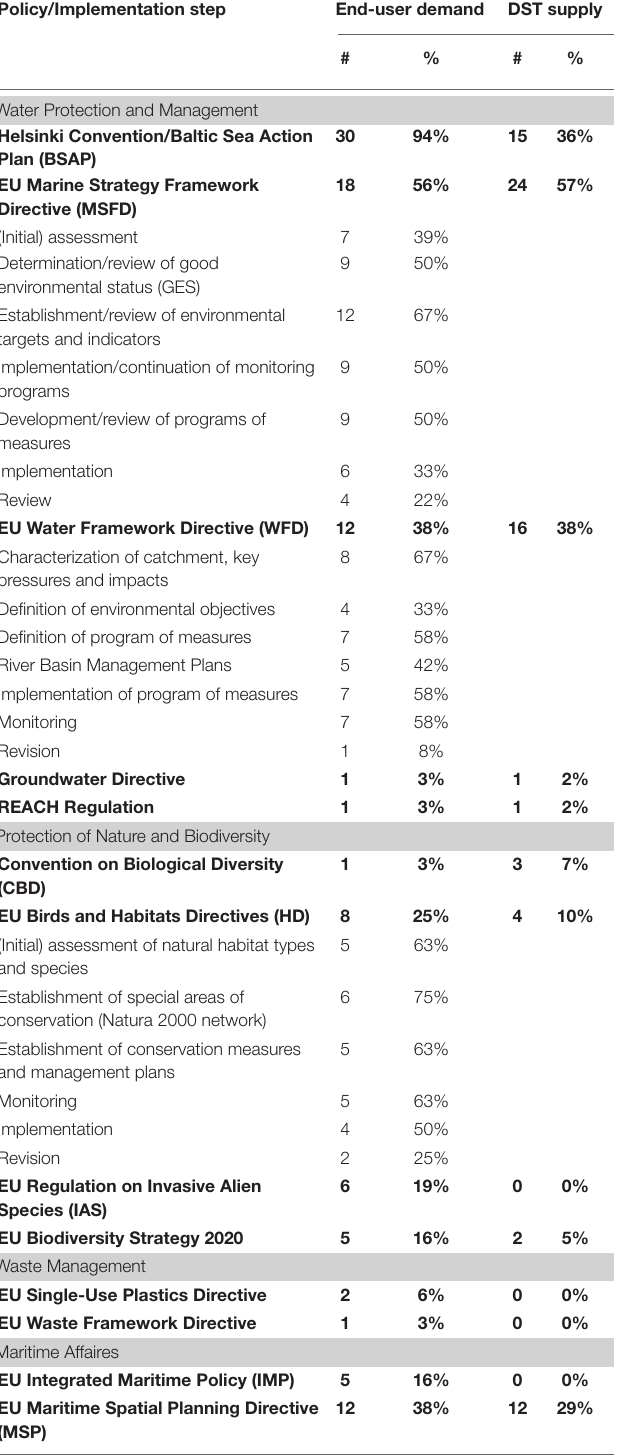
TABLE 4 | End-user needs for decision support tools (DSTs) addressing coastal and marine policies (bold) and their specific implementation steps (based on end-user survey) are shown in comparison to DSTs available to support each policy (based on DST review). Included policies are listed according to major policy